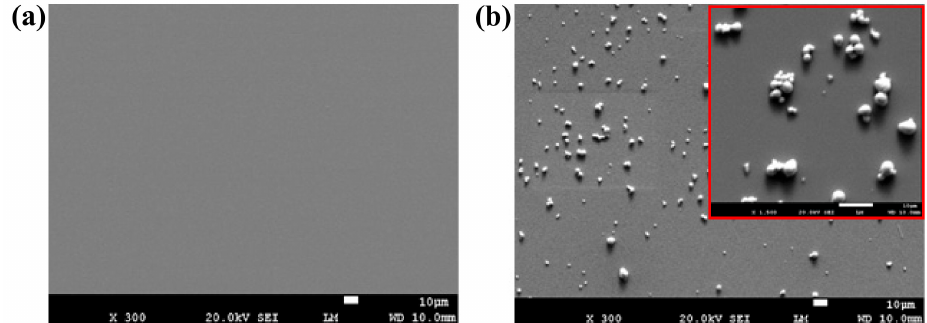
Figure 2. SEM images of the working electrode surface of the chemical sensor ( a ) before and ( b ) after drop-castingBi-nanoparticlessolution, wheretheinsetin( b )showstheaggregatesformedbyBinanoparticles with a higher